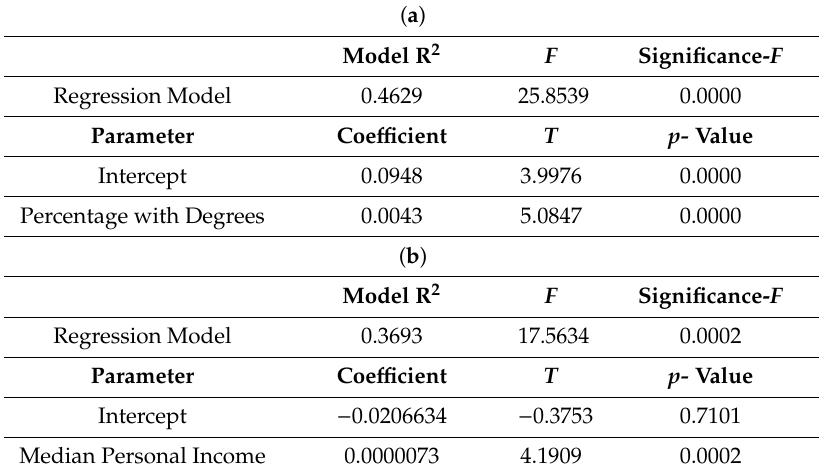
Table 6. Single linear models for excellent QoUL. ( a ) Results of the linear regression predicting excellent QoUL using university degree as a subjective variable. ( b ) Results of the linear regression predicting excellent QoUL using median income as a subjective